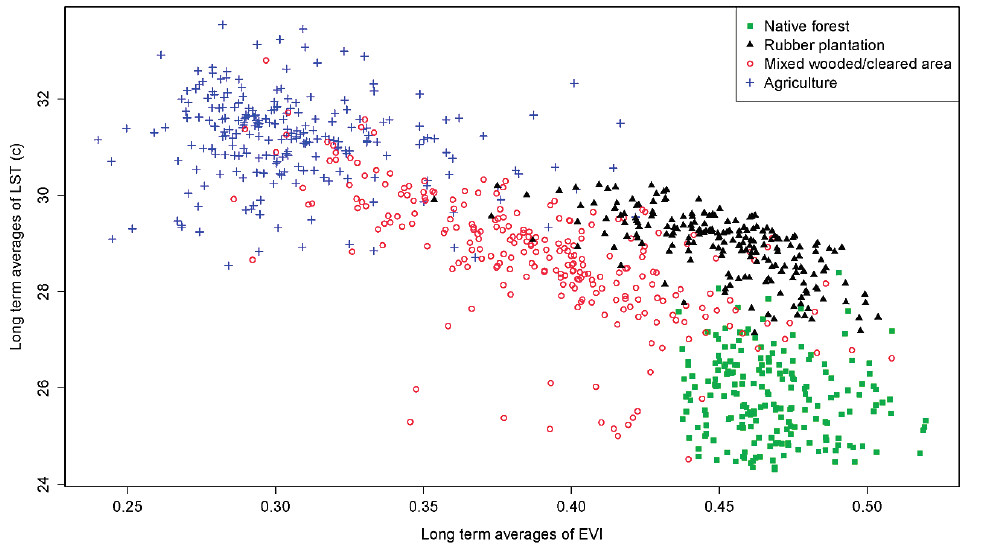
Figure 5. Long-term means (2006–2012) of LST and EVI for 800 MODIS samples within the four land cover